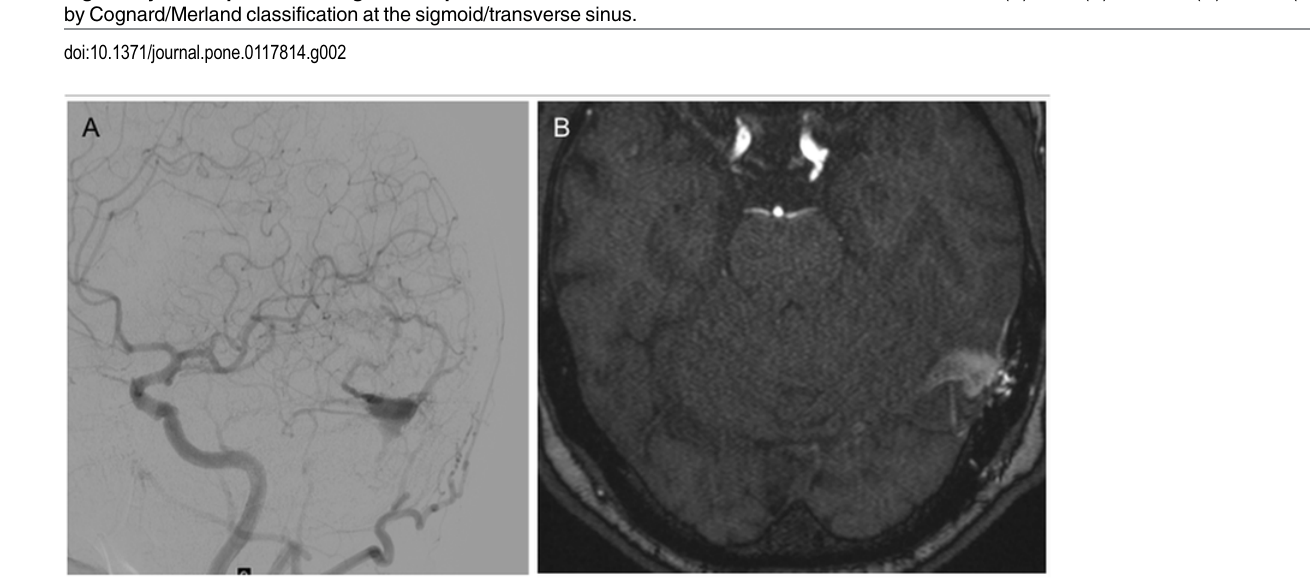
PLOS ONE | DOI:10.1371/journal.pone.0117814 February 17,